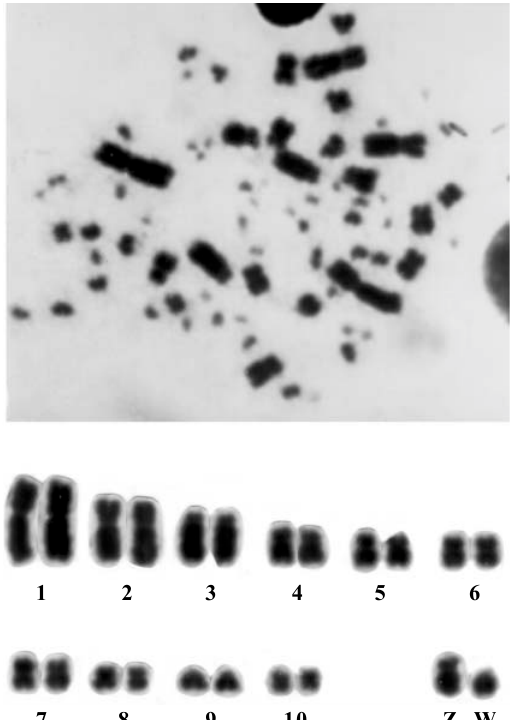
Figure 1 - Mitotic metaphase and female karyotype of Mycteria americana